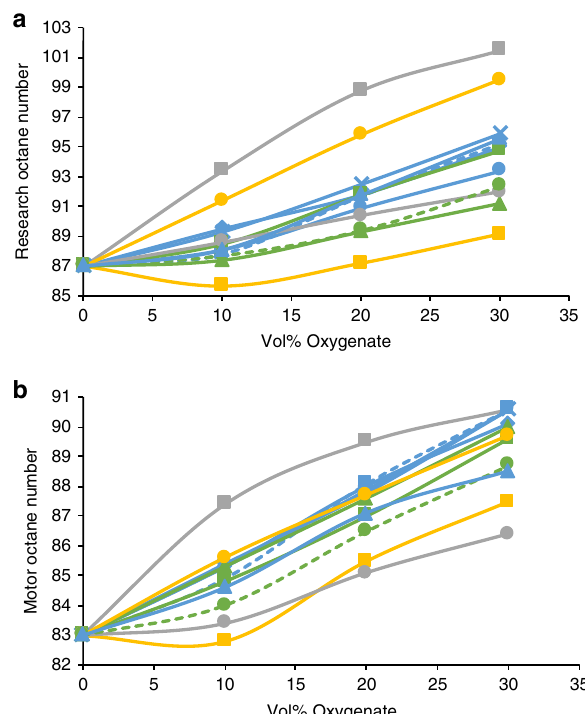
Fig. 3 Octane numbers of short-chain ketones blended into a model gasoline. Three ethyl ketones (green), fi ve methyl ketones (blue), other ketones (yellow), ethanol (gray square), and 1-butanol (gray circle) were added into CARBOB at 10, 20, and 30 Vol%. a , b Research octane numbers ( a ) and Motor octane numbers ( b ) were measured by ASTM methods D2699 and D2700, respectively. Short-chain ketones produced by engineered S . albus strains were shown as a dashed line. 2-methyl-3- pentanone (green circle), 3-hexanone (green triangle), 3-pentanone (green square), 4-methyl-2-pentanone (blue circle), acetone (blue triangle), 3- methyl-2-butanone (blue square), 2-pentanone (blue diamond), butanone (blue cross), cyclopentanone (yellow circle), 2,4-dimethyl-3-pentanone (yellow square). CARBOB Reformulated Blend-stock for Oxygenate Blending formula mandated by the state of